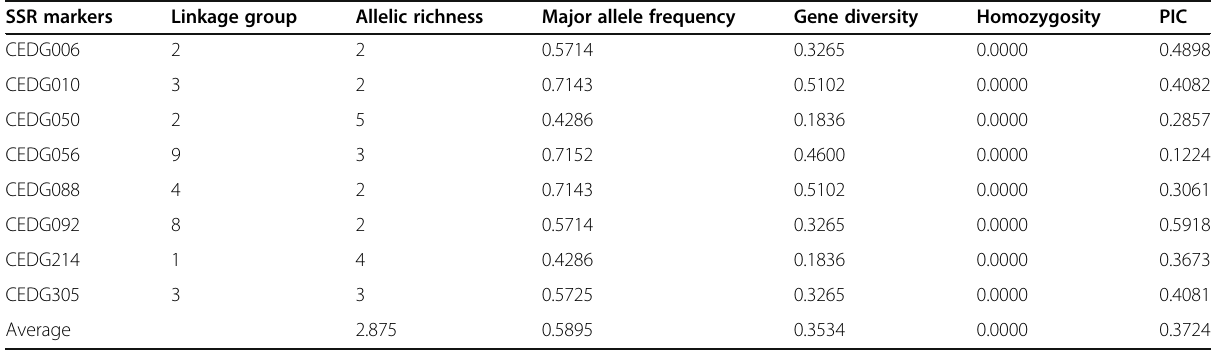
Table 5 The polymorphic SSR markers used with their allelic richness, allele frequency, gene diversity, and the PIC values SSR markers Linkage group Allelic